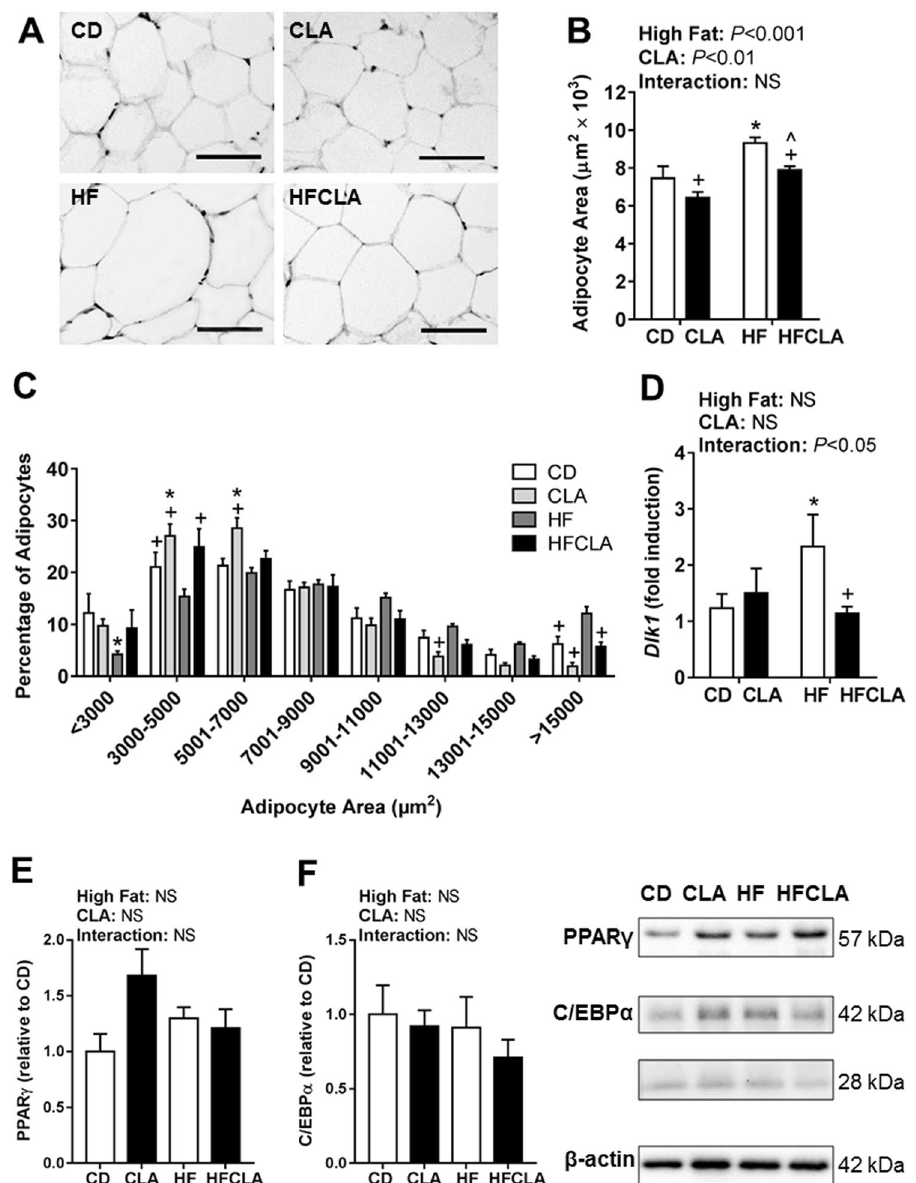
Figure 4. Retroperitoneal adipose tissue histology and expression of adipogenic markers. ( A ) Representative adipocyte histological images of adipose tissue sections (scale bar represents 100 µ m). (B) Average adipocyte size and (C) adipocyte size distribution ( n = 5–6 litters/group). (D) Dlk1 expression determined by qPCR ( n = 5–6 litters/group). Cropped versions of representative western blots of adipogenic regulators (E) PPAR γ and (F) C/EBP α ( n = 5 litters/group) are presented. Data expressed as means ± SEM, where * P < 0.05 vs CD, ^ P < 0.05 vs CLA and + P < 0.05 vs